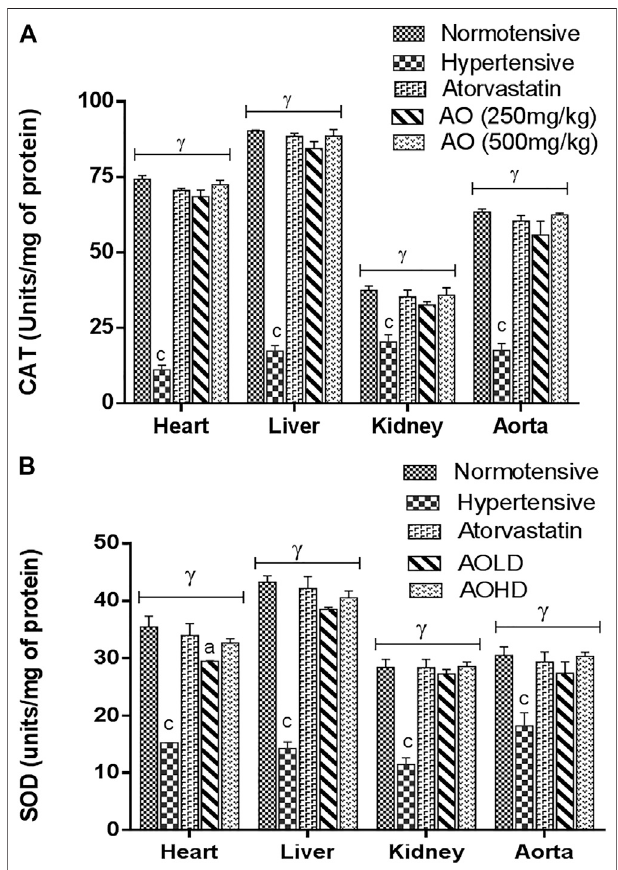
FIGURE 3 | Effect of administration of A. of fi cinarum (AO) on (A) catalase (CAT) and (B) superoxide dismutase (SOD) enzyme in various organs of chronic obesogenic diet-fed hypertensive rats. The results are stated as means ± S.E.M ( n (cid:1) 6), where a (cid:1) p < 0.05, b (cid:1) p < 0.01, and c (cid:1) p < 0.001 vs normotensiverats. α (cid:1) p < 0.05, β (cid:1) p < 0.01,and ɣ (cid:1) p <